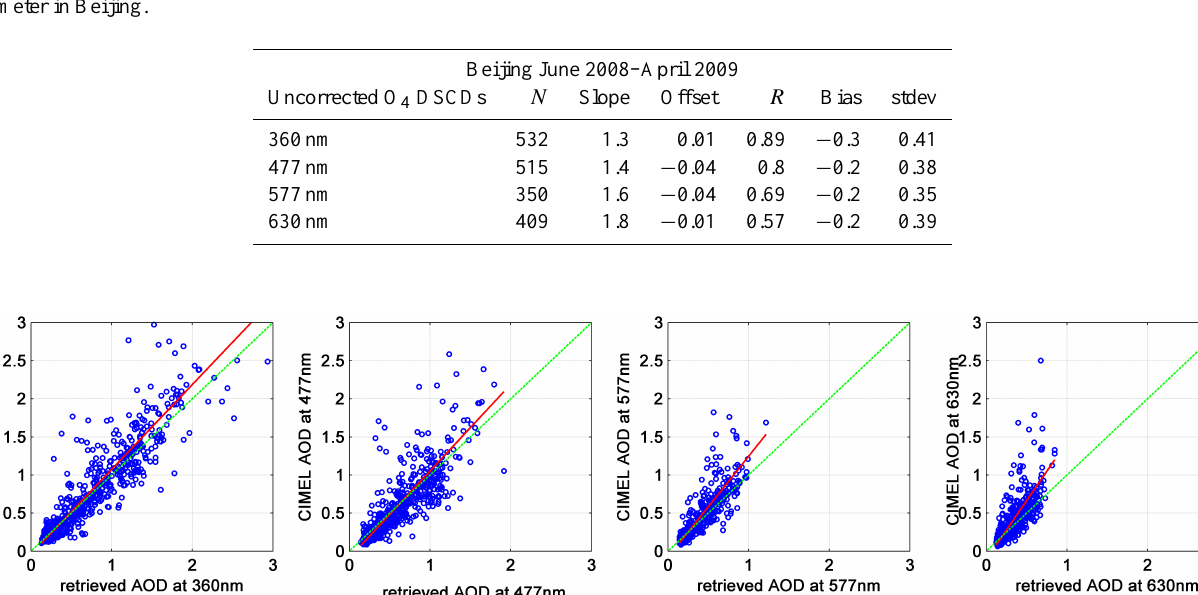
Table 3. Linear regression fit parameters (slope and offset) and statistical parameters (correlation coefficient R , bias, standard deviation (stdev), number of points ( N )) for the comparison of total AODs retrieved from the uncorrected O 4 DSCDs and the values from a sunpho- tometer in Beijing.